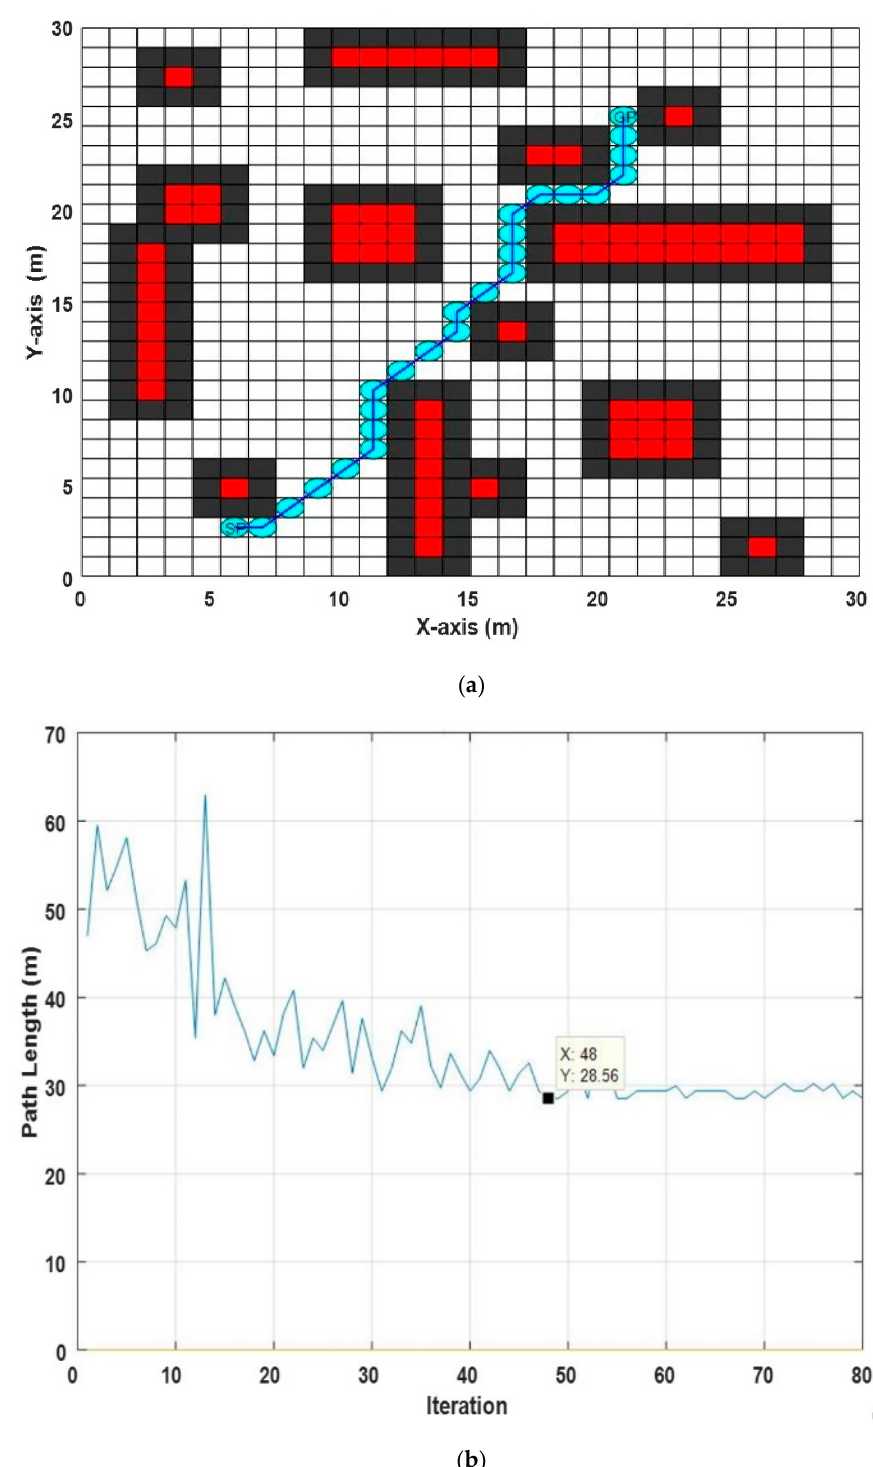
Figure 13. The best path achieved within the AACO Grid-based static environment 2. Figure 13. The results of the proposed ABACO-based path planning algorithm in grid static environment 2, ( a ) the best path obtained, ( b ) the convergence curve of the proposed ABACO based path planning